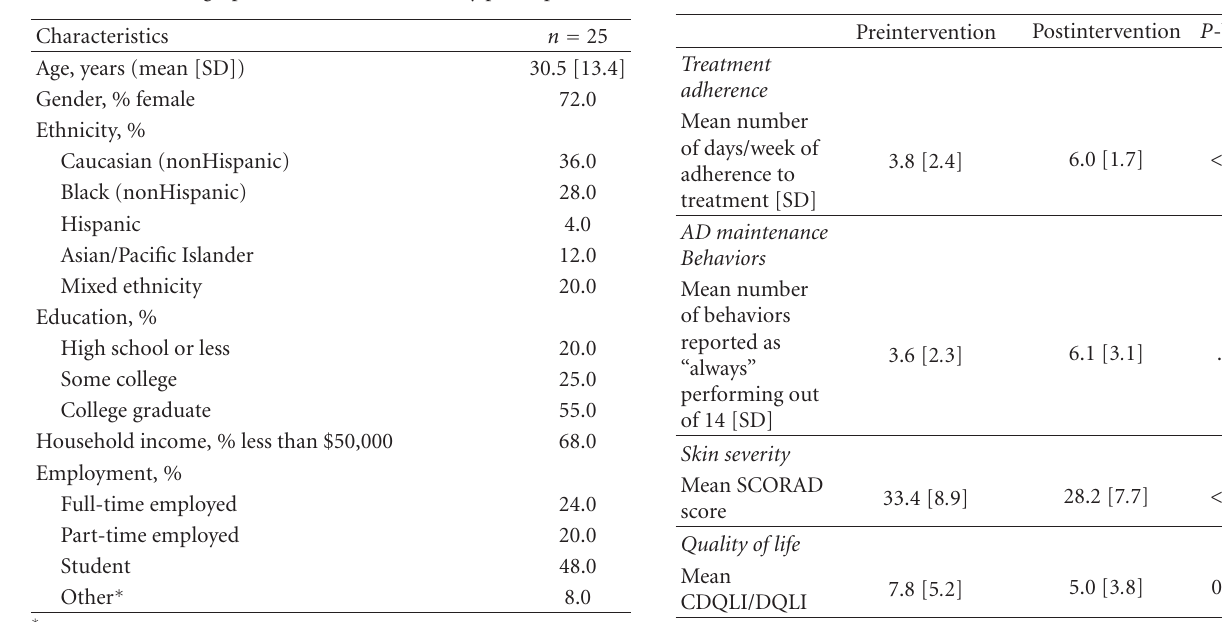
Table 1: Demographic characteristics of study participants. Table 2: Pre- and Postintervention